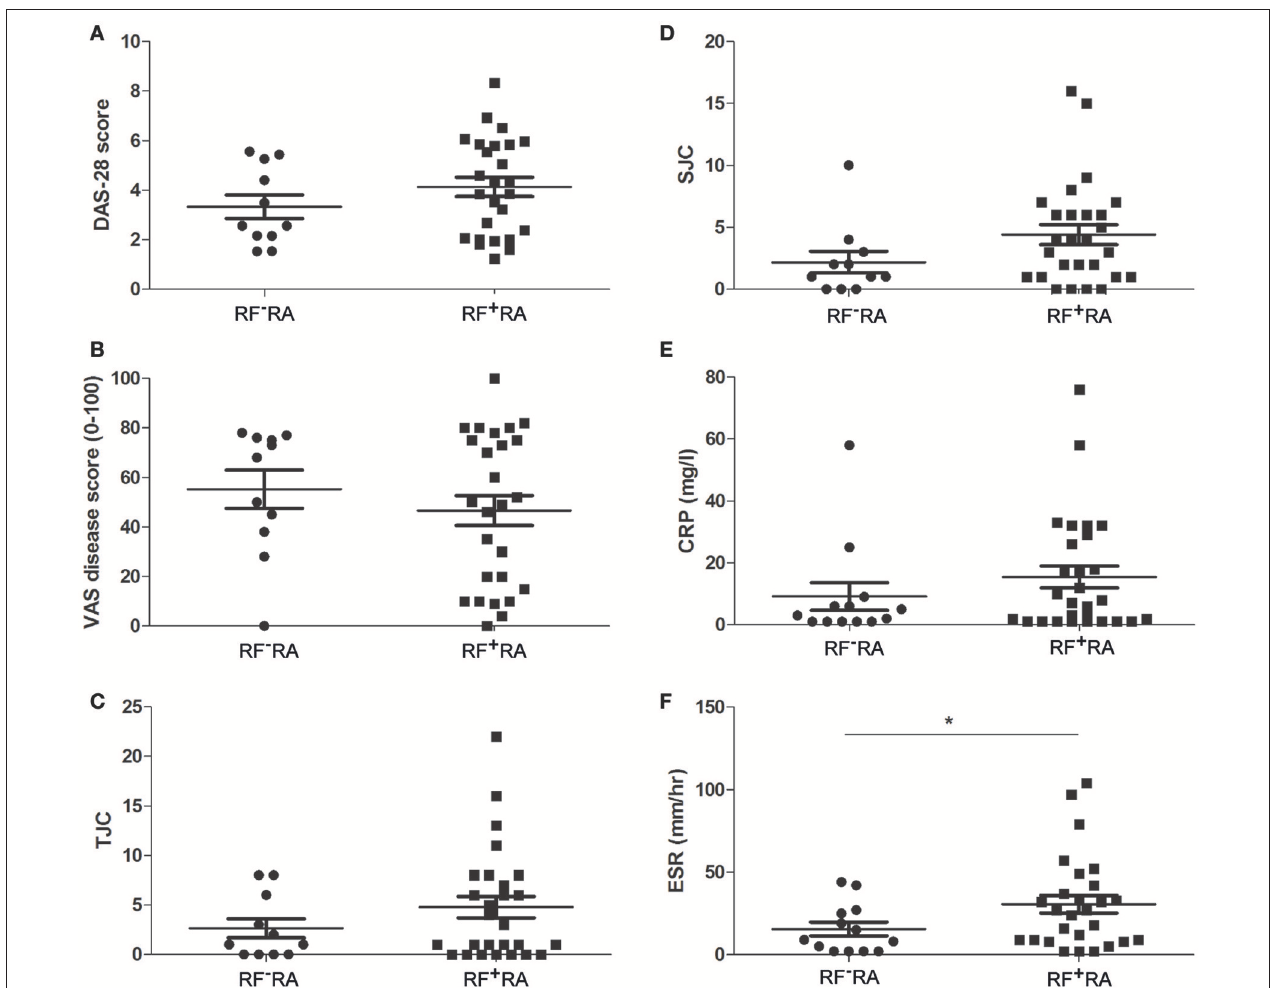
FIGURE 3 | Clinical parameters related to the presence of IgM-RF in blood. Based on the presence of IgM-RF in blood the RA patients were divided 2 groups, RF + RA and RF − RA patients. Clinical parameters were obtained at time of blood donation. DAS28 (A) , VAS disease activity (B) , TJC (C), and SJC (D) , and CRP and ESR levels (E,F) of RF + RA and RF − RA patients are shown. Statistically significant differences were determined by Mann-Whitney test, * p <